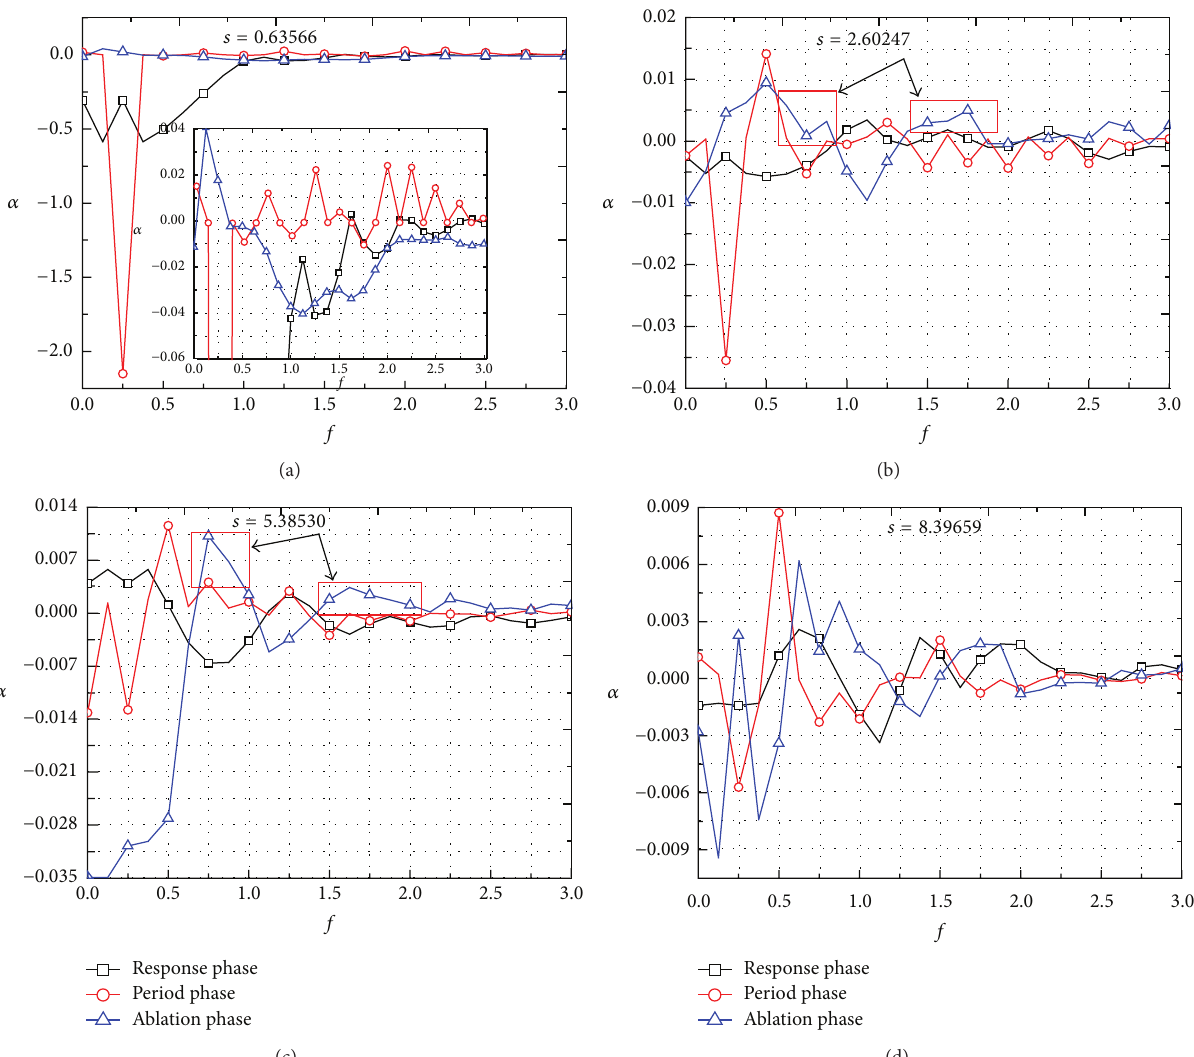
Figure 11: Growth of different frequency disturbances in the boundary layer along streamwise in 3